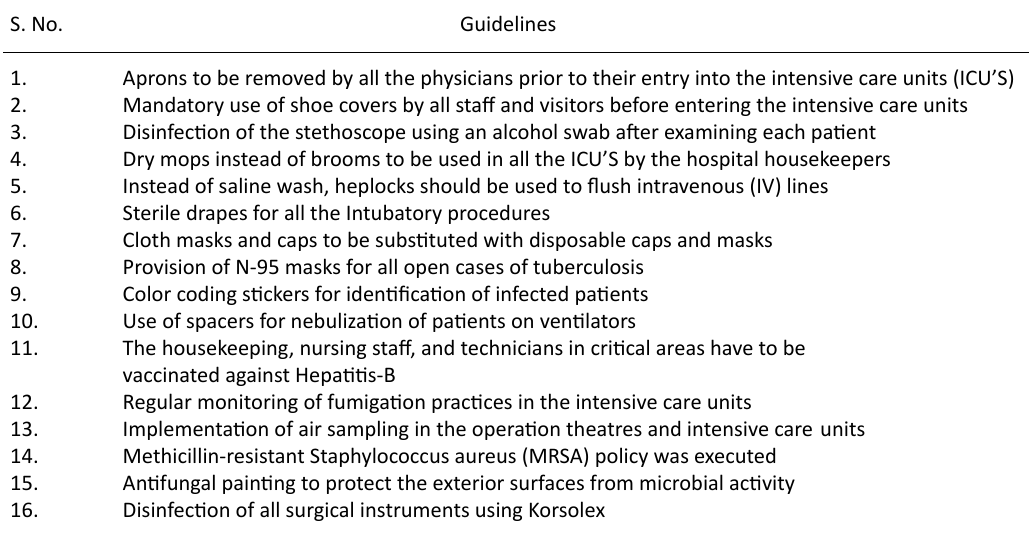
table 1. Guidelines formulated by the Infection control committee S.